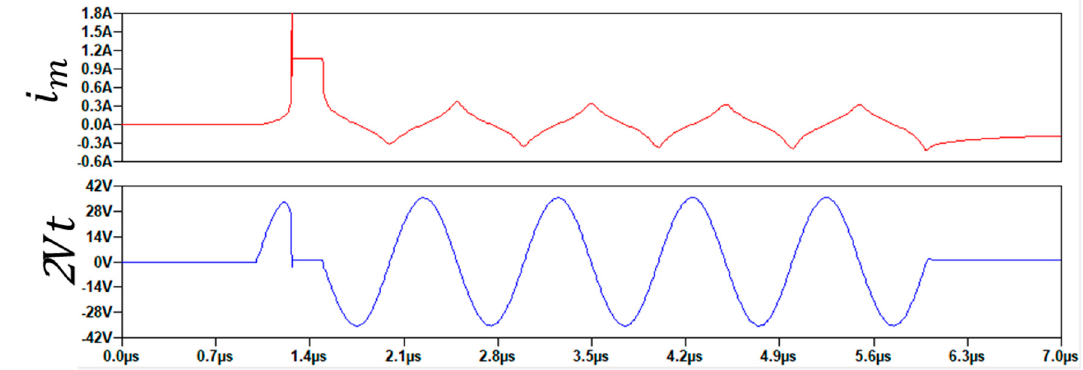
Figure 3. Magnetization current ( top ) and load voltage ( bottom ) in the circuit of Figure 1 when the transformer features ∅ M = 2.6 µ Vs saturation limit and Lm = 19 µ H magnetization inductance. During saturation, the driver circuit reaches its 1A current limit, and a voltage distortion appears in output.